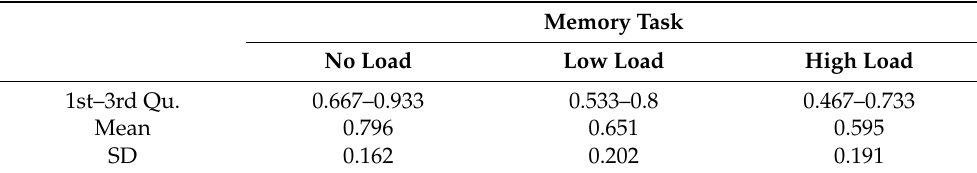
Table 1. Accuracy (range 0–1) in the memory task, reported separately for the three Cognitive Load conditions (No Load, Low Load–LL, High